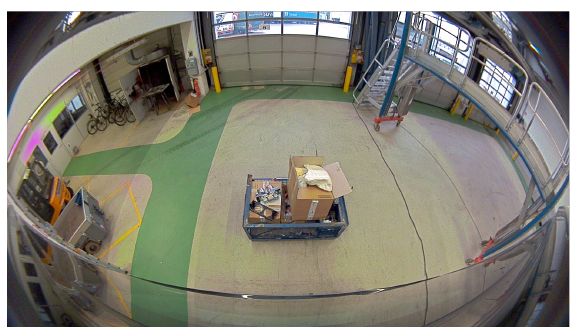
Figure 3. Exemplary raw-data from one of the bus-mounted top-view cameras